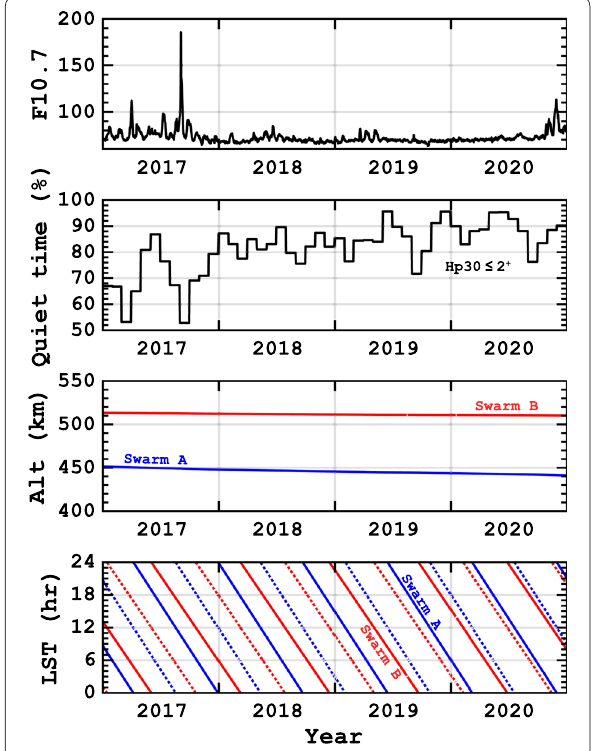
Fig. 1 From top to bottom, daily F 10.7 index, monthly percent occurrence rate of geomagnetically quiet time (Hp30 ≤ 2 + ), altitudes of Swarm A (blue) and B (red), local solar time of Swarm A and B over the equator for ascending (solid line) and descending (dashed line)